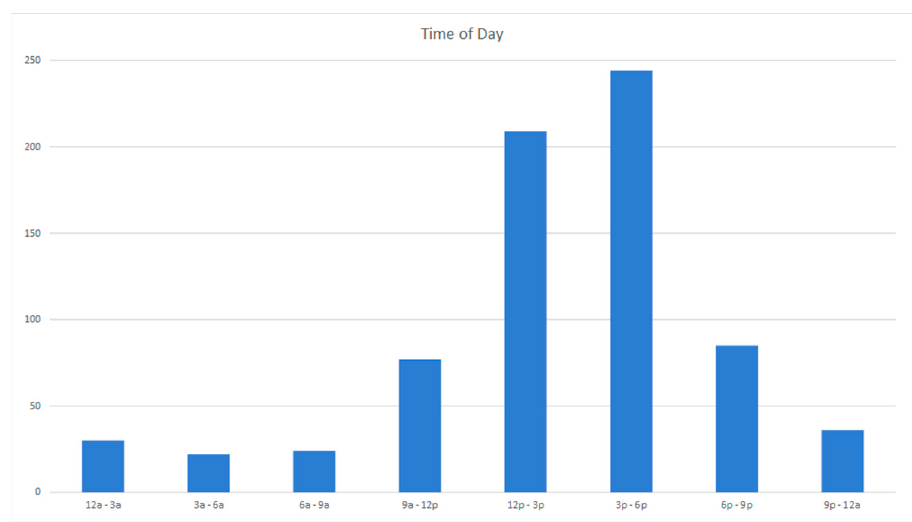
Figure 5. Diurnal cycle of Virginia tornado activity. Table 1. Notable Virginia tornado statistics.